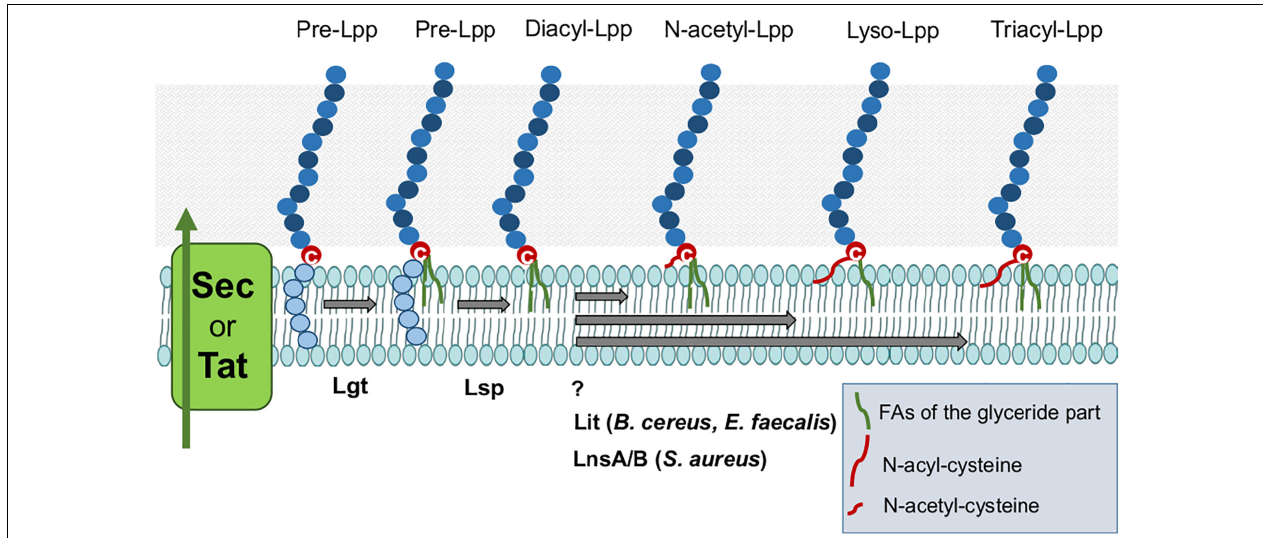
FIGURE 4 | Lipoproteins biosynthesis modification in Firmicutes. After Sec/Tat dependent export, precursor Lpp are located on the cytoplasmic membrane where they can be modified by processing enzymes to yield the mature Lpp. The first enzyme Lgt transfers the diacylglyceryl group from phosphatidylglycerol to the sulfhydryl group of the invariant cysteine residue in the lipobox. The second enzyme Lsp recognizes the diacylglyceryl modified lipo signal peptide and cleaves between the amino acid at position –1 and the lipid-modified cysteine residue at +1, obtaining the diacyl-Lpp. N-acetyl-Lpp are modified by unknown enzyme. Lyso-Lpp are modified by Lit enzyme. And Tri-acyl (N-acyl)-Lpp are processed by LnsAB in S. aureus .